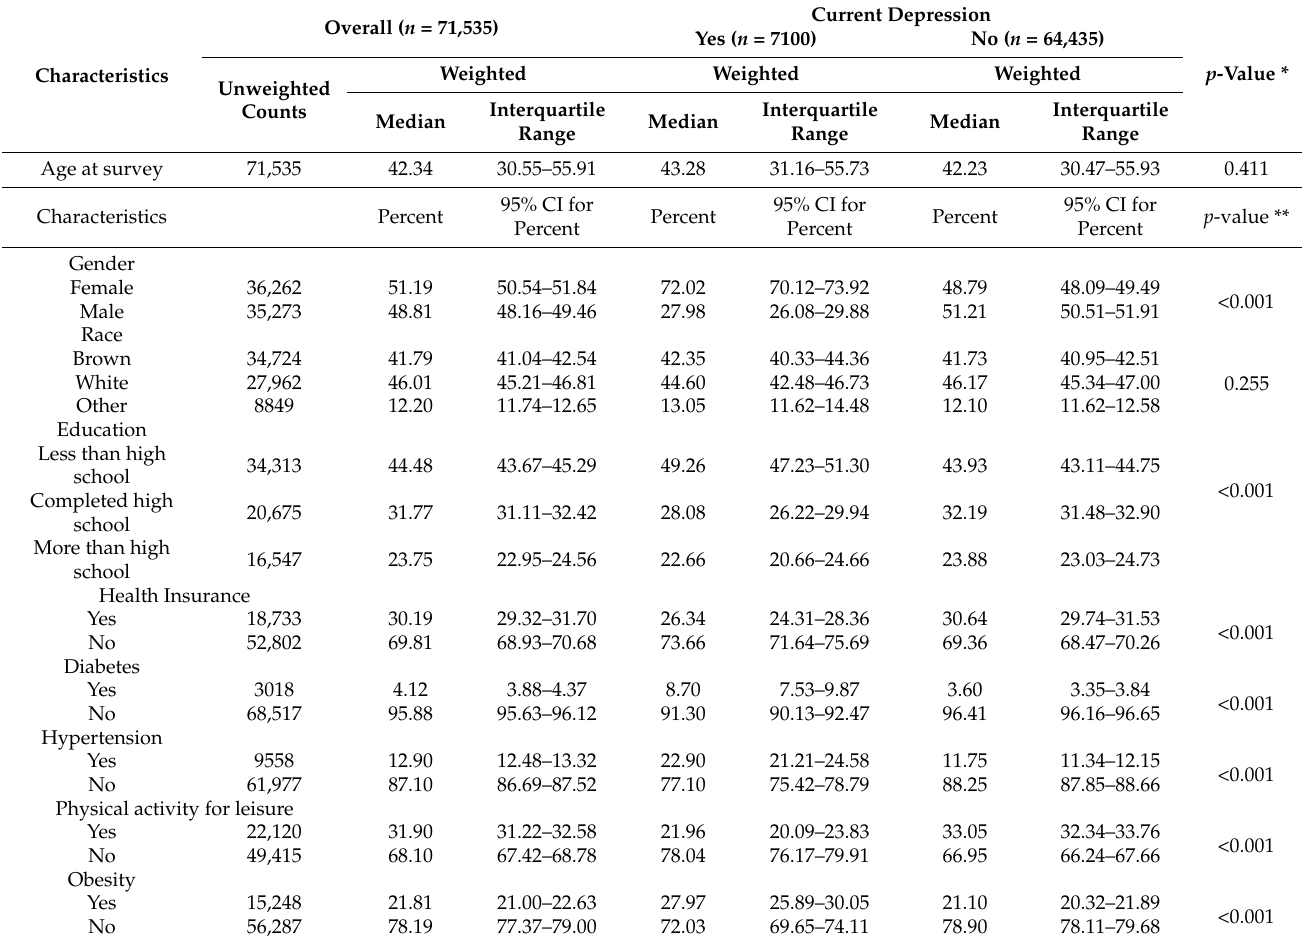
Table 1. Characteristics of the final study sample. Brazilian National Health Survey,